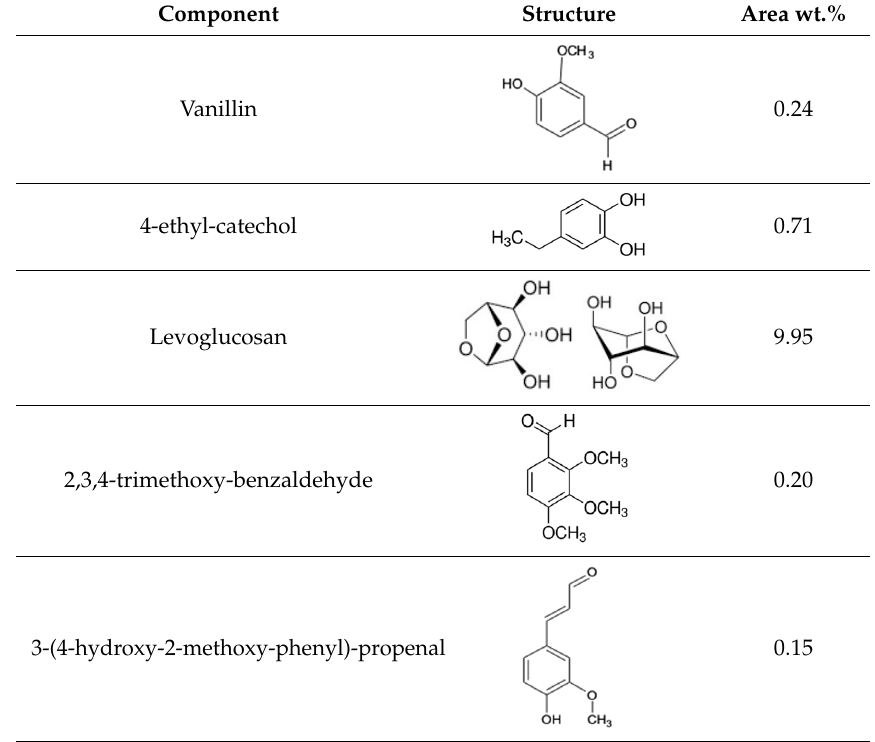
Table 3. Cont. Component Structure